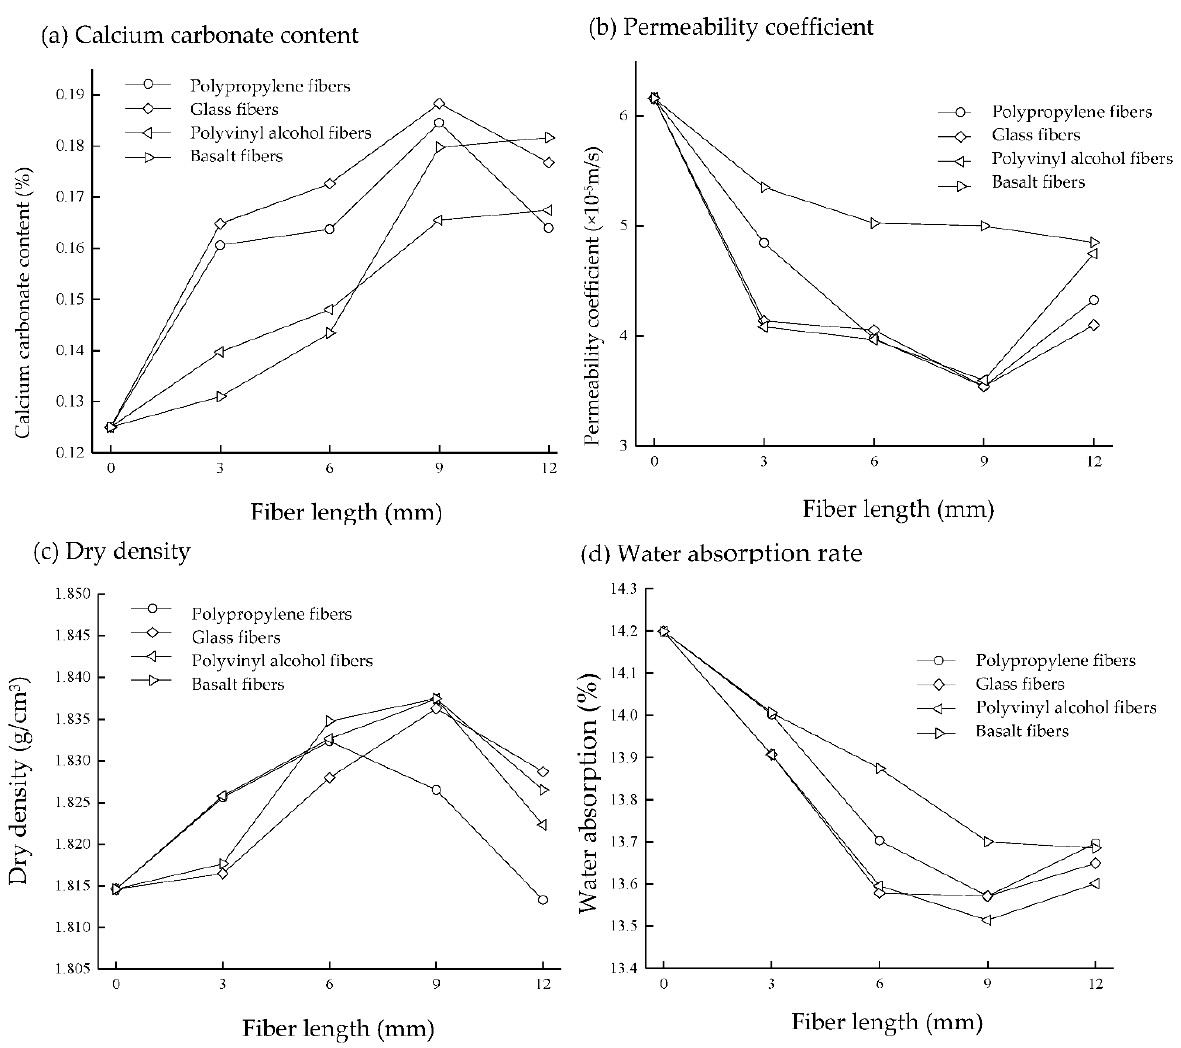
Figure 4. Physical properties: ( a ) Calcium carbonate content; ( b ) Permeability coefficient; ( c ) Dry density; ( d ) Water absorption rate.